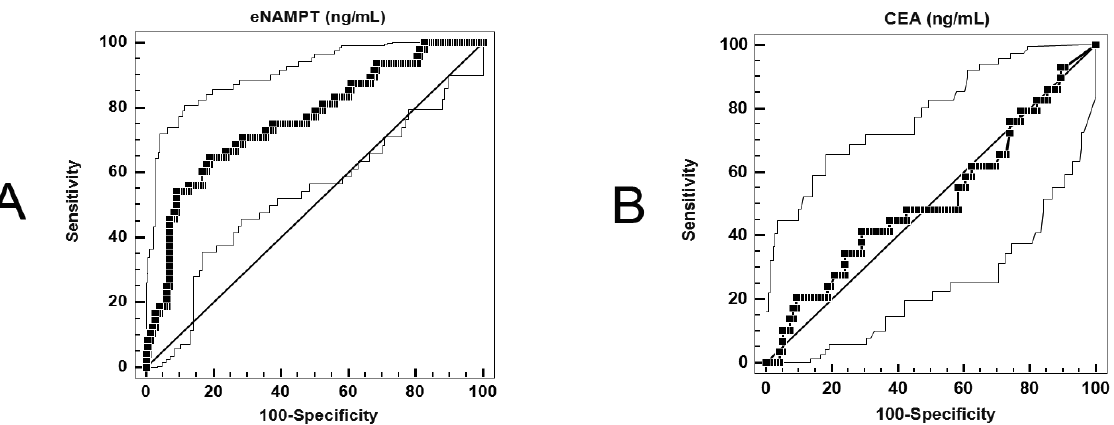
Figure 2. ROC curves for baseline eNAMPT ( A ) and CEA ( B ) in determining the malignant potential of of polyps.